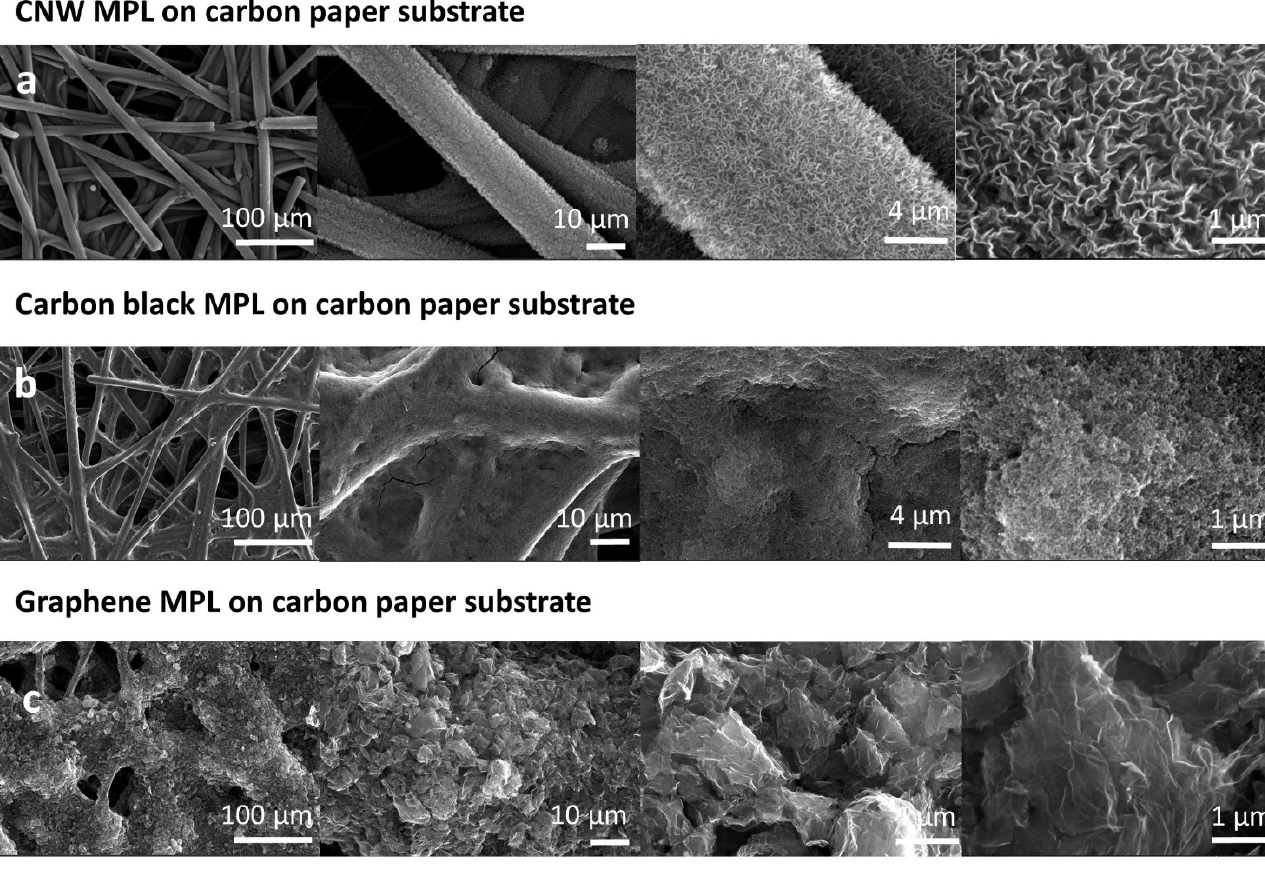
Figure 2. Top-view SEM images showing the MPL anchoring pattern on top of the carbon paper and the material structural details for ( a ) carbon nanowalls, ( b ) carbon black, and ( c ) graphene, at different resolutions.